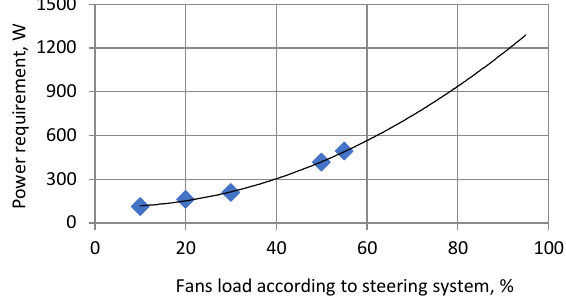
Fig. 16. Cooling fan power consumption depending on the % of the load defined by the control system in laboratory